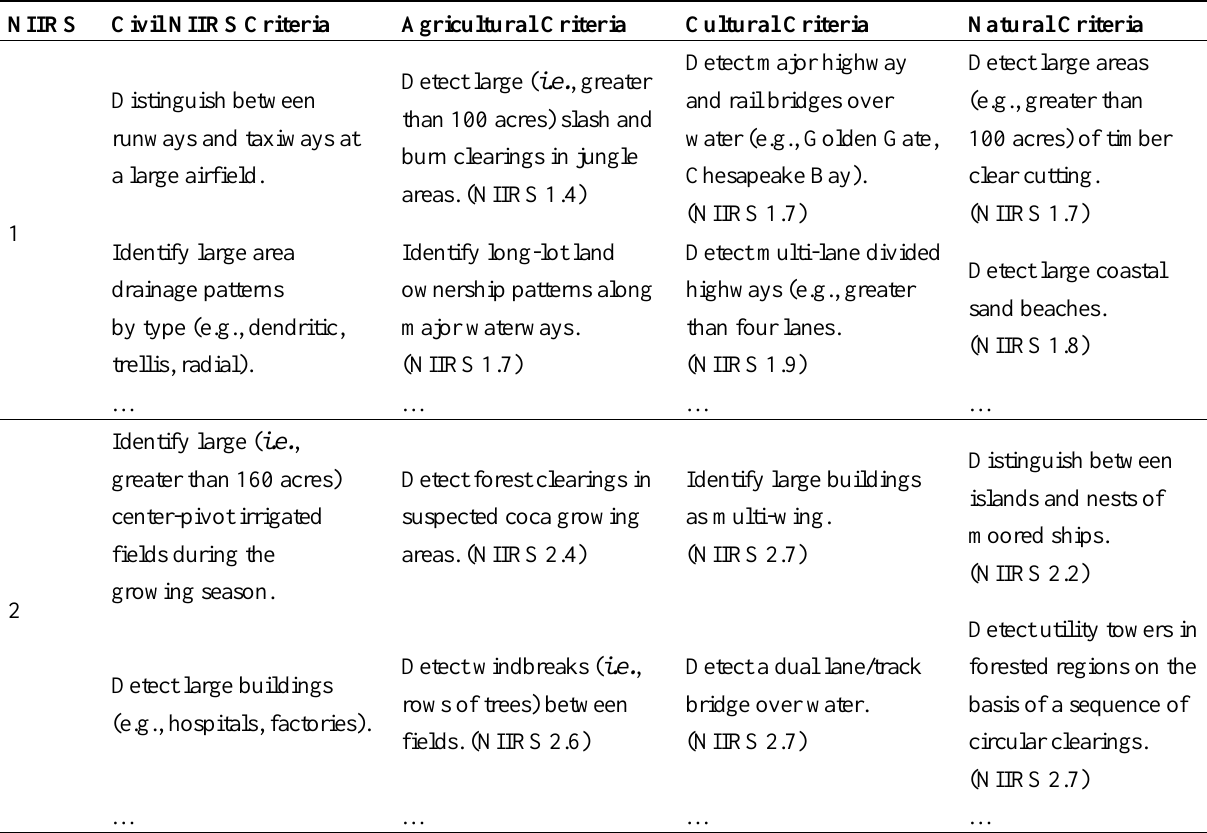
Table 9. Additional NIIRS